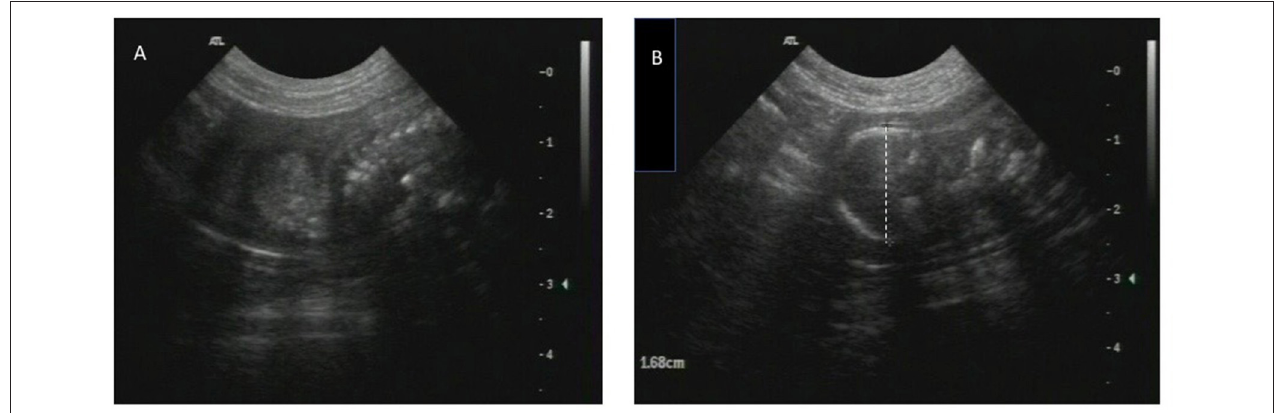
FIGURE 2 | Images of ultrasound. (A,B) A collapsed fetus in the left uterine horn with BPD of 16.8mm surrounded by echogenic fluid (D69).